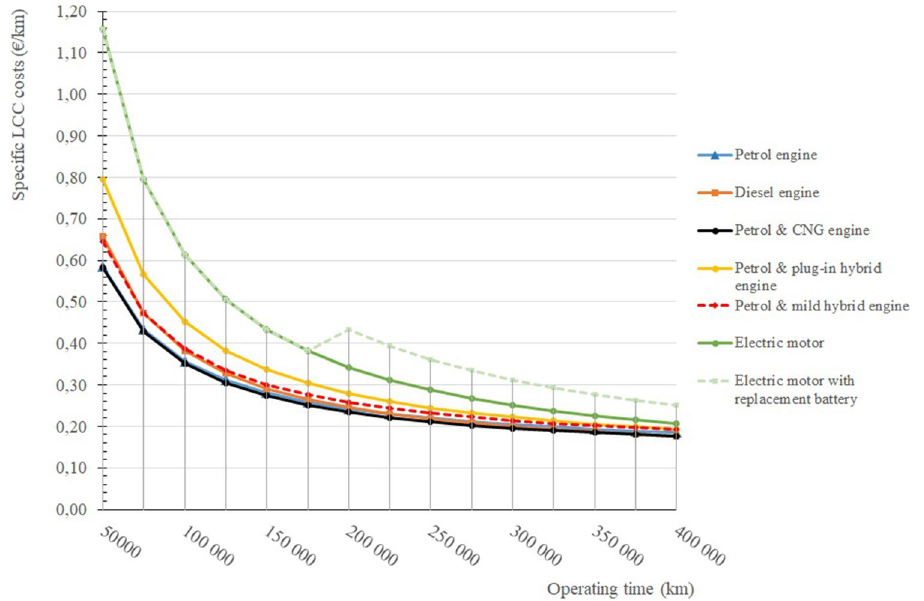
Figure 11. Specific life cycle costs of selected passenger car